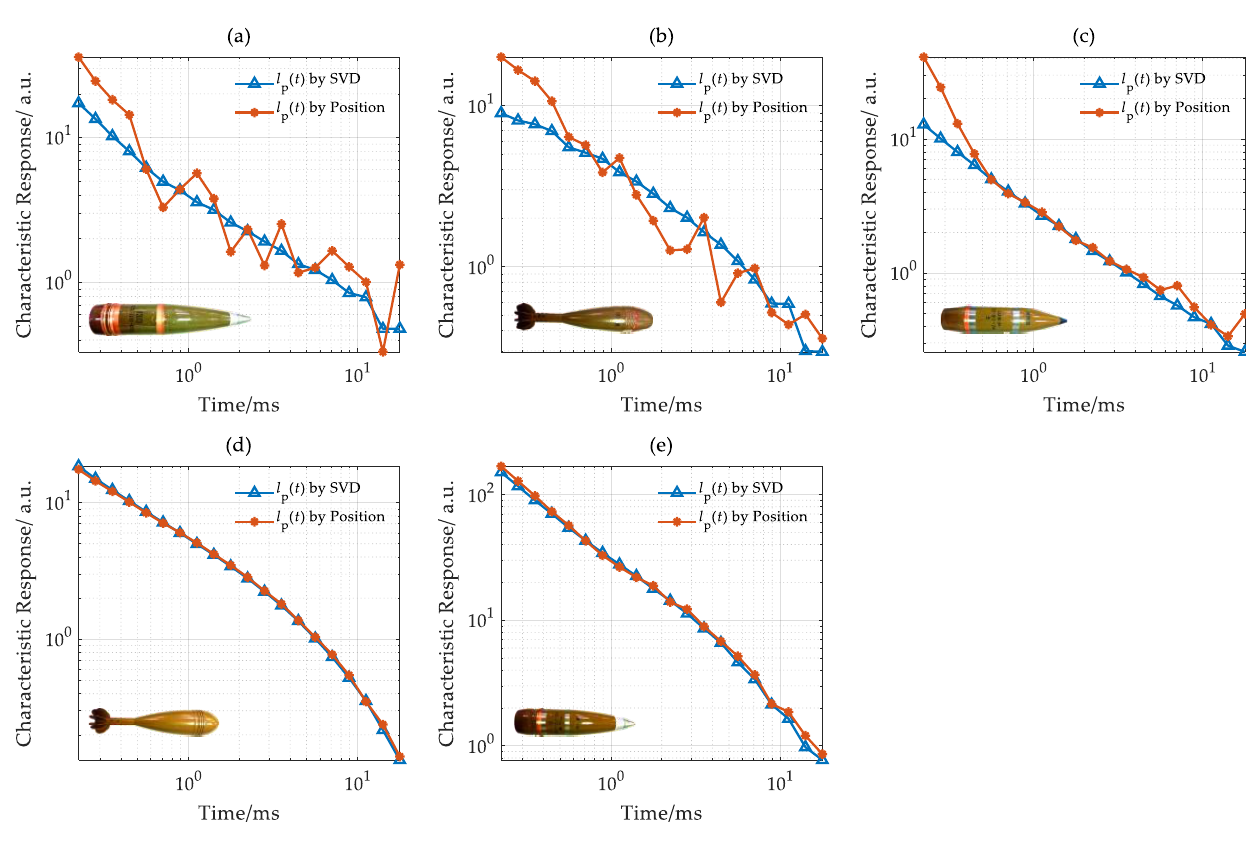
Figure 12. Characteristic response in the survey line with y = 6.0 m. ( a ) U12, ( b ) U11, ( c ) U10, ( d ) U9, ( e ) U8.